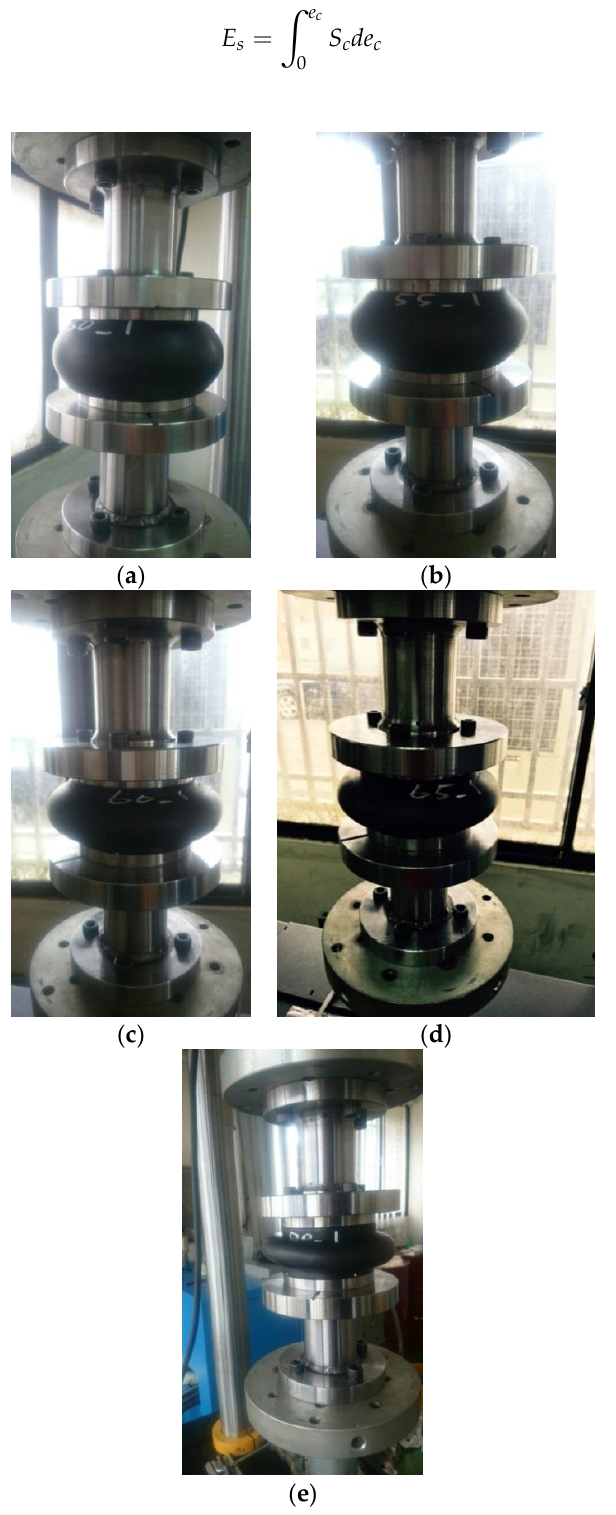
Figure 2. Experimental observations of the tested hollow-cylinder rubber fenders with different wall thicknesses under maximum compressive deformation (50 mm): ( a ) 25.0, ( b ) 22.5, ( c ) 20.0, ( d ) 17.5, and ( e ) 15.0 mm.